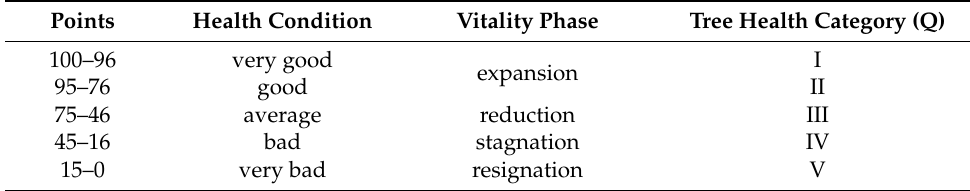
Table 3. Examined trees vitality, health status and category.